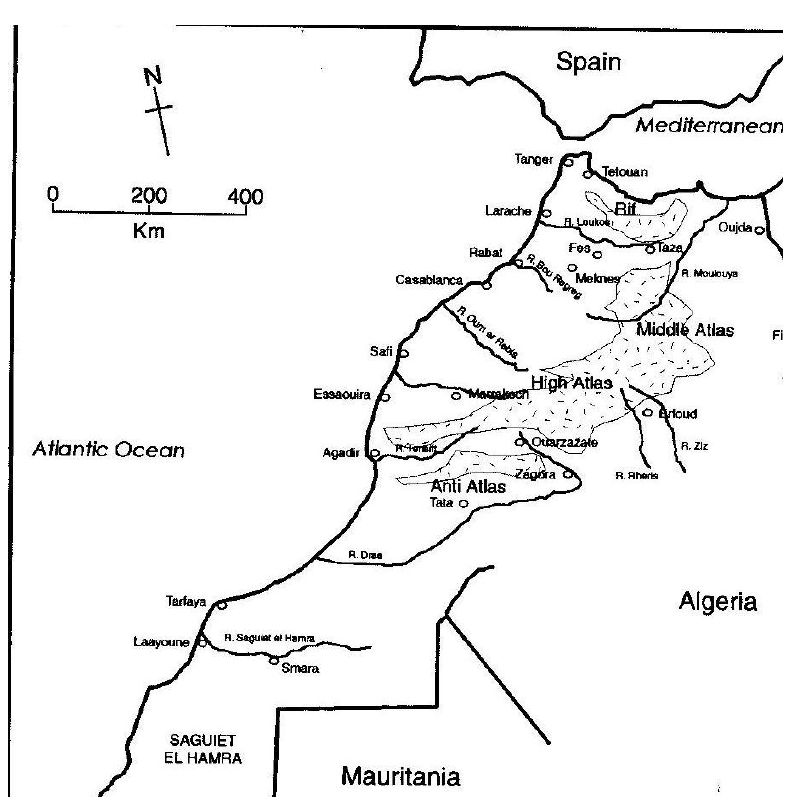
Figure 1. Map of